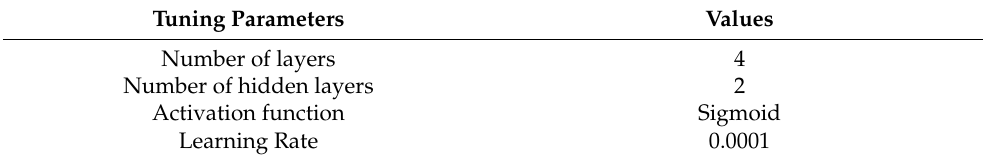
Table 3. The adopted parameters of BPNN.